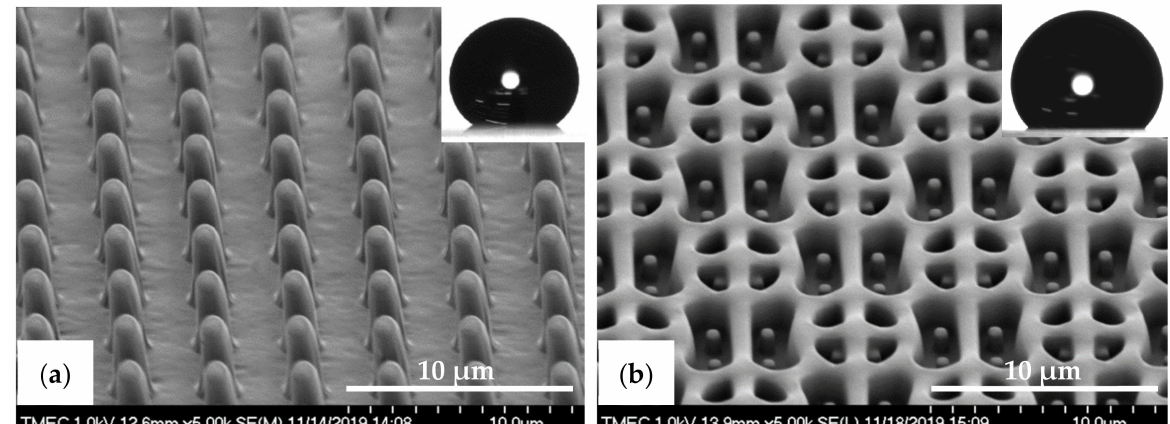
Figure 7. Tilted-view SEM images of the PDMS micro-structures fabricated by soft lithography process before scratch test. ( a ) PDMS-PIL pattern (designed pattern size: diameter: 2.0 µ m, height: 2.5 µ m) and ( b ) PDMS-C-RESS pattern (designed pattern size: diameter: 1.0 µ m, height: 2.5 µ m). The insets show water droplet contact angle images on those PDMS surfaces.